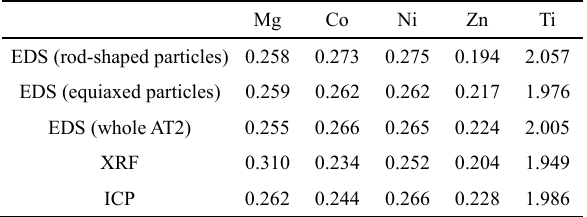
Table 1 Quantitative analysis of AT2 after sintering at 1400 ℃ (relative ratios of the molar content of each element) Mg Co Ni Zn Ti